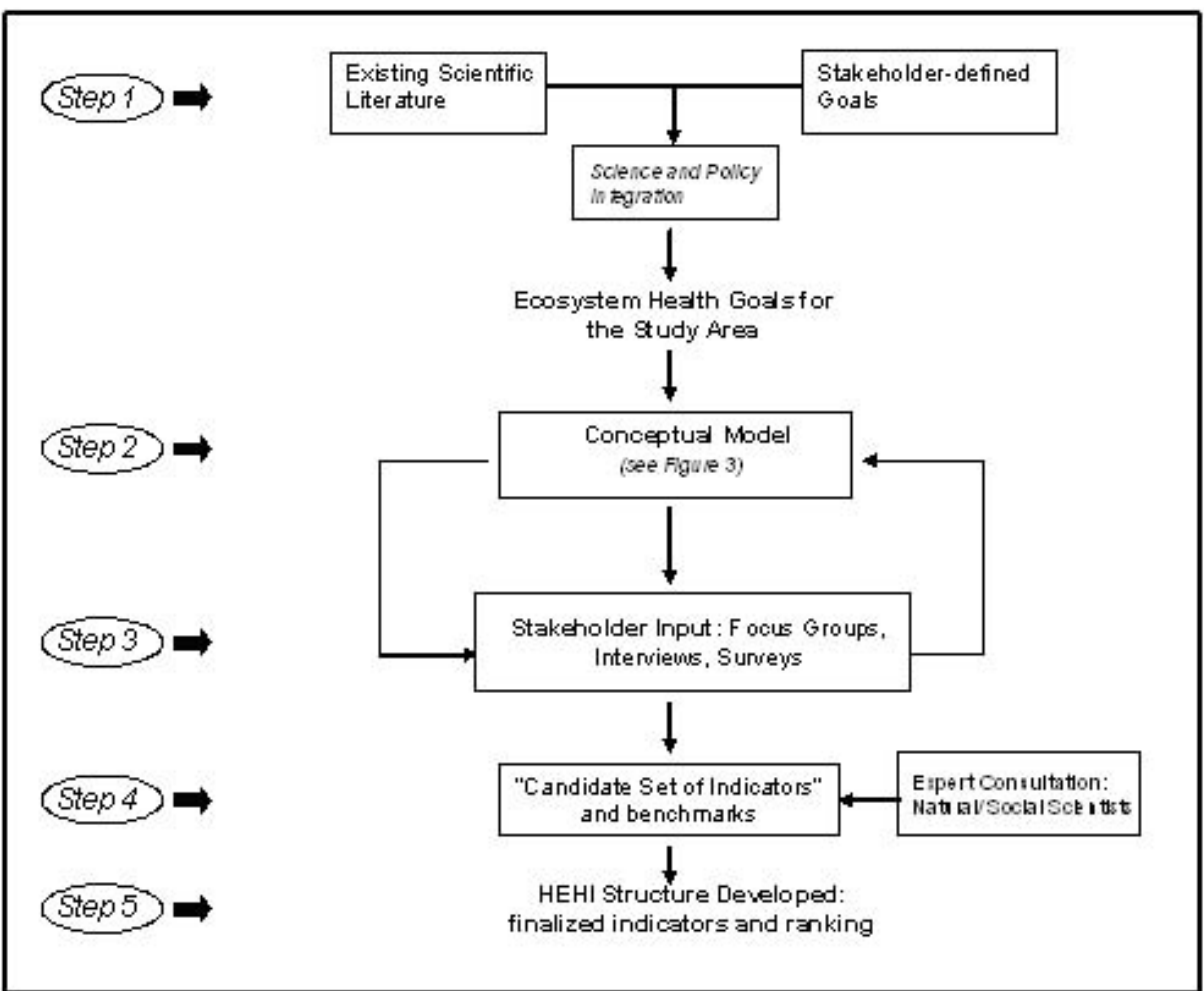
Fig. 2. Steps for developing the holistic ecosystem health indicator (HEHI) for a collaborative management